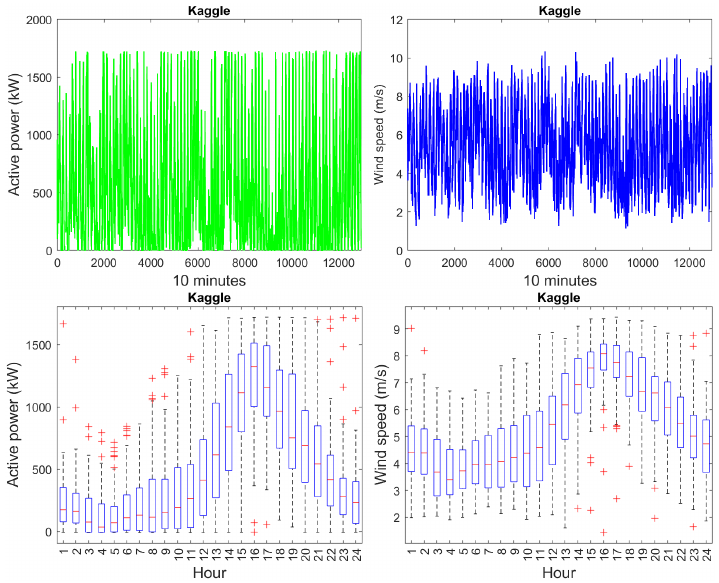
Figure 5. Wind power ( top left ) and wind speed ( top right ) data from Kaggle wind turbine; box plot of hourly data for wind power ( bottom left ) and wind speed ( bottom right ).